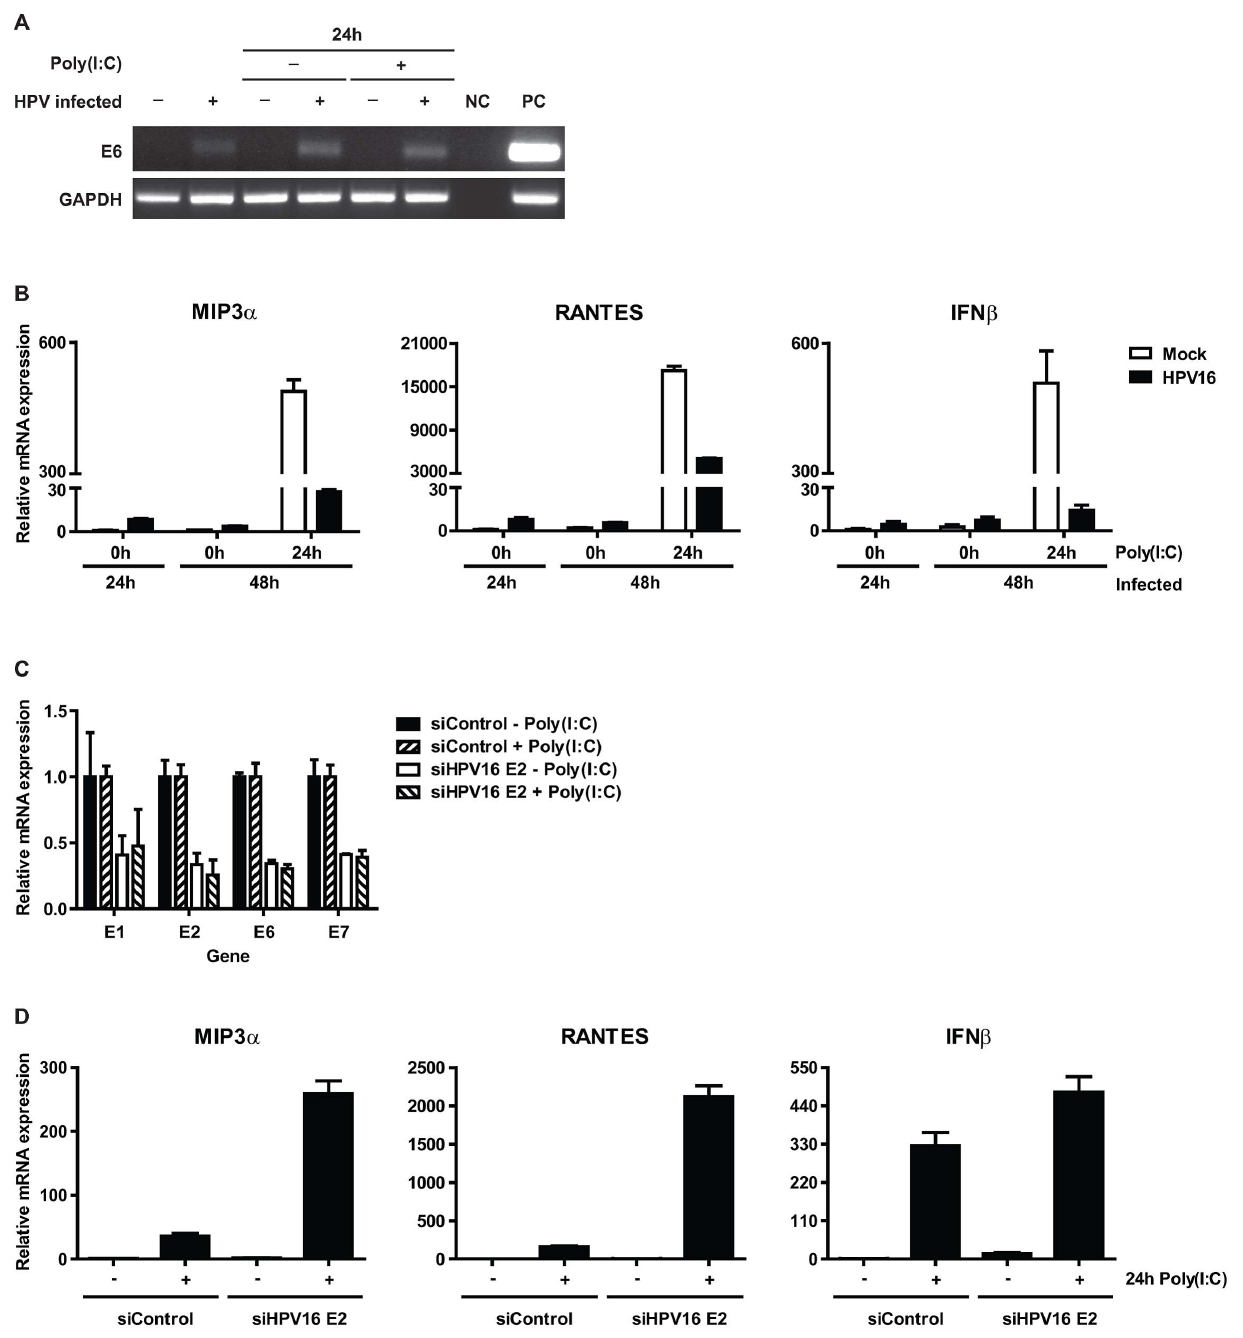
Figure 3. Expression of human papillomaviral transcripts are required to impair cytokine expression of poly(I:C) stimulated keratinocytes. ( A , B ) Cytokine expression at the initial stage of HPV16 infection. Primary basal layer human foreskin keratinocytes were infected with native HPV16. ( A ) Viral early gene E6 expression was analyzed 1 and 2 (24 h poly(I:C)) days after infection by PCR. NC: negative control, PC: positive control, HPV16 + KCs. ( B ) MIP3a , RANTES and IFN b expression was measured by qRT-PCR. Gene expression was normalized against GAPDH mRNA levels and standardized against the 0 h poly(I:C) stimulated non-infected cells. Similar results were observed in two independent experiments. ( C , D ) Poly(I:C)-induced cytokine expression in HPV + KCs transfected with control siRNA (siControl) or siRNA targeting HPV16 E2 (siHPV16 E2). E1 , E2 , E6 , E7 ( C ) as well as MIP3a , RANTES , and IFN b ( D ) expression was analyzed by qRT-PCR. Gene expression was normalized against GAPDH mRNA levels and standardized against no poly(I:C) siControl. For all three genes the response to poly(I:C) was significantly higher when HPV16 E2 was suppressed (p , 0.001, one-way ANOVA). hrHPV + KCs compared to uninfected KCs (Figure 4A and B). cultures and expression was not influenced by poly(I:C) activation The upregulation of UCHL1 in hrHPV + KCs was confirmed by (Figure 4C). Furthermore, UCHL1 upregulation at the protein RT-qPCR in both foreskin and vaginal epithelial hrHPV + KC level was tested and shown for three different hrHPV + KCs by